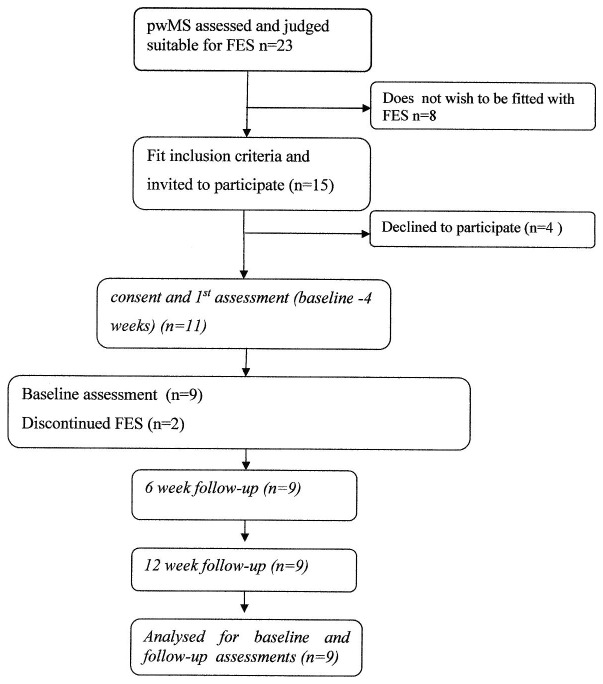
CONSORT diagram.